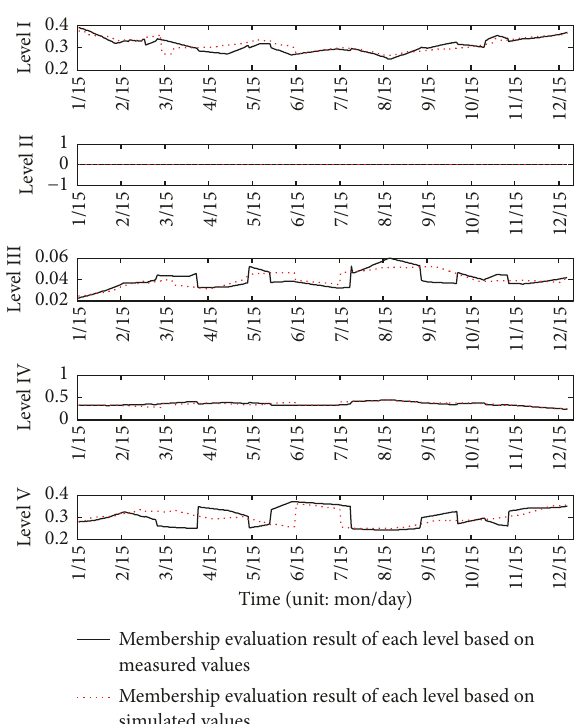
Figure 4: Membership evaluation result of each level based on the measured values and simulated values of UKF.